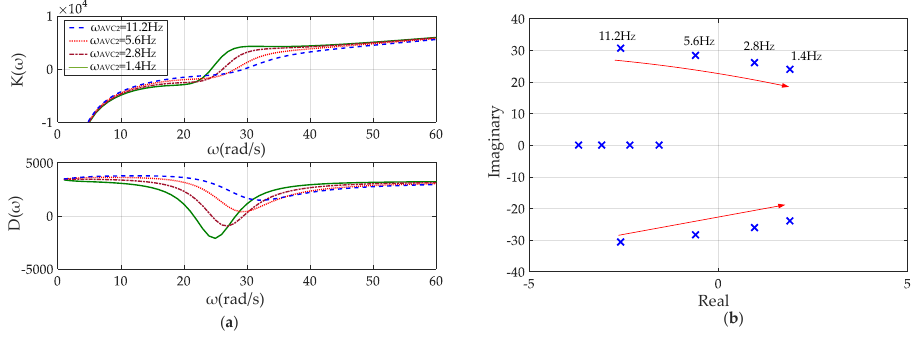
Figure 9. ( a ) Frequency response curves of spring and damping coe ffi cients for the entire system under di ff erent bandwidths of AVC; ( b ) corresponding eigenvalue